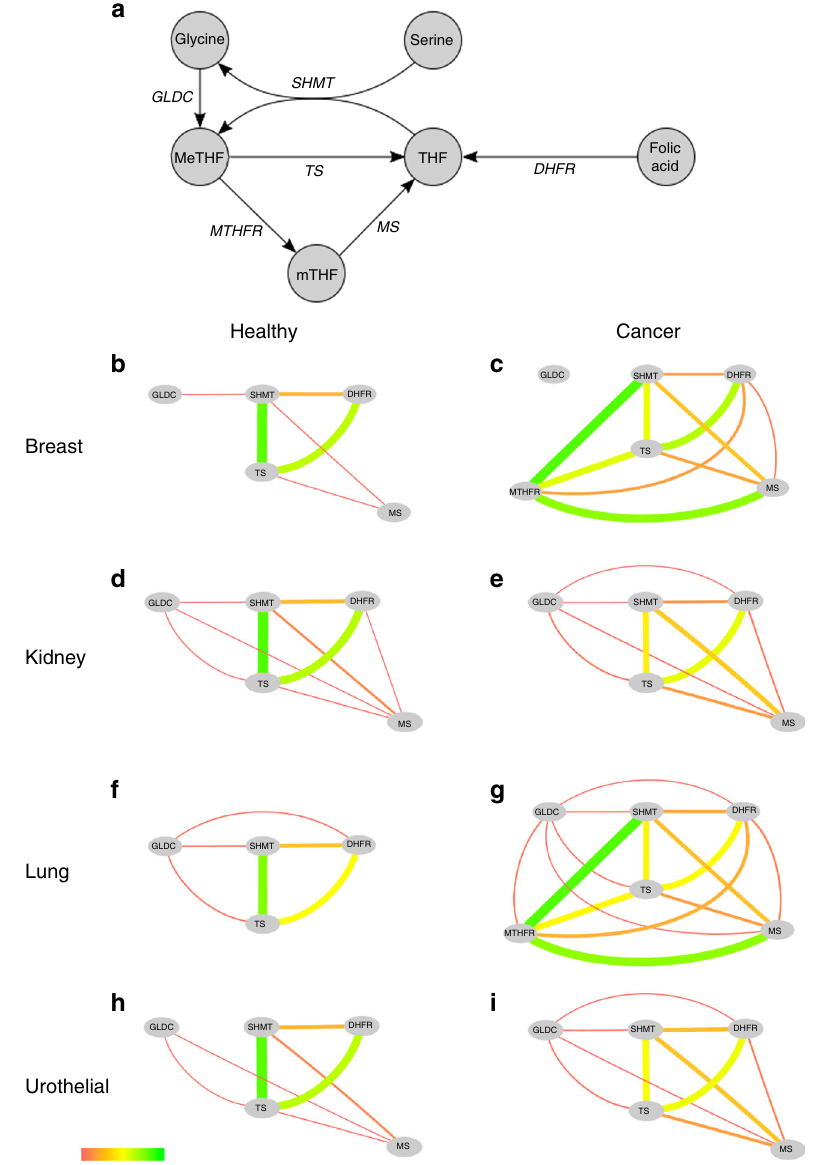
Fig. 6 Flux correlation changes in the folate cycle. a Simpli fi ed representation of the folate cycle. In this representation, nodes represent metabolites and edges represent metabolic reactions. b – i Reaction correlation coef fi cients in the metabolic system depicted in A for four types of healthy and cancer tissues. In these representations, nodes represent metabolic reactions and the edge colour represents the fl ux correlation value between the reactions connected by the edge; the colour bar represents the correlations value from red (0.5) to green (1.0). Abbreviations: THF, tetrahydrofolate; MeTHF, 5 – 10- methylene-tetrahydrofolate; mTHF, 5-methyl-tetrahydrofolate; DHFR, dihydrofolate reductase; GLDC, glycine decarboxylase; MS, methionine synthase; MTHFR, methylene-tetrahydrofolate reductase; SHMT, serine hydroxymethyl transferase; TS, thymidylate